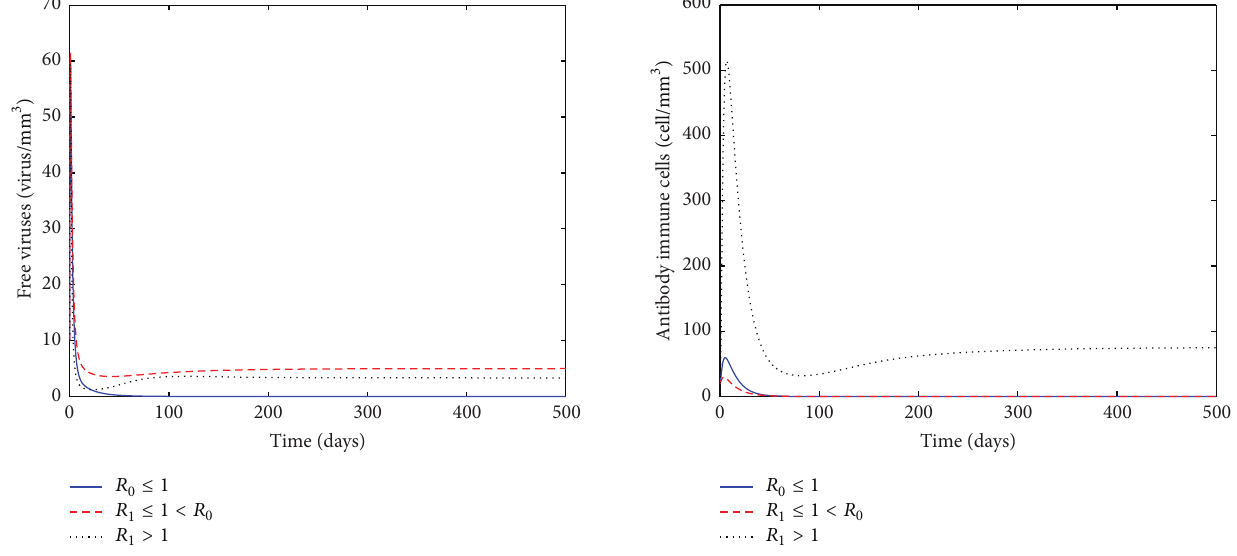
Figure 10: The evolution of antibody immune cells for model (33)–